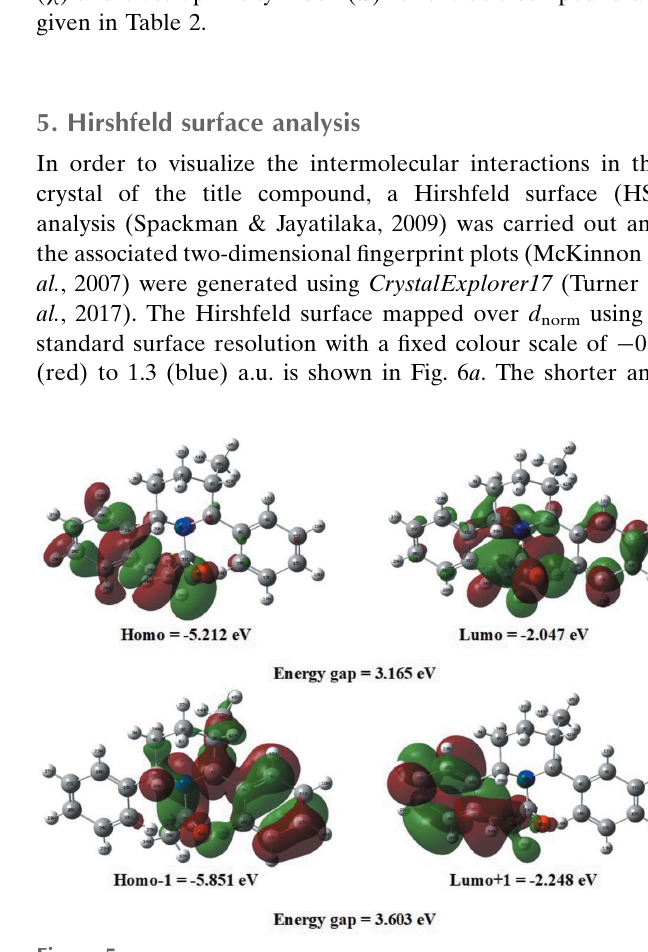
Figure 5 The frontier molecular orbitals (FMOs) of the title